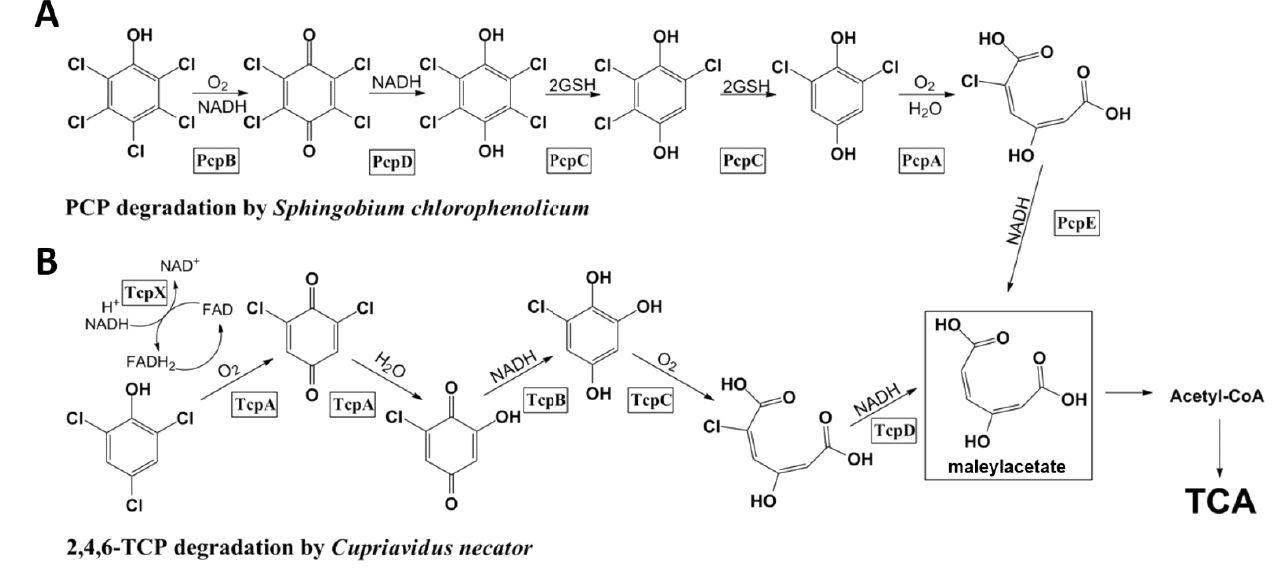
Figure 1. Degradation pathway of pentachlorophenol (PCP) in Sphingobium chlorophenolicum and 2,4,6-TCP in Cupriavidus necator . ( A ) PCP is converted to maleylacetate through a series of enzymatic transformations. PcpR is responsible for the transcriptional control of PcpA, PcpB and PcpE; and ( B ) 2,4,6-TCP is converted to maleylacetate through a series of enzymatic transformations. TcpR is responsible for the transcriptional control of TcpX, TcpA, TcpB, TcpC and